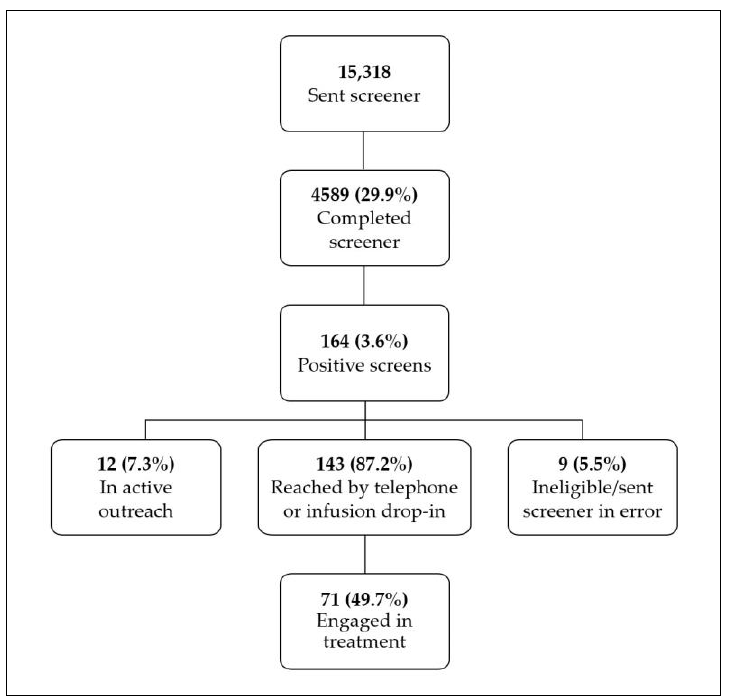
Figure 5. Tobacco screener completion and referrals for unique patients between June 25, 2019 and April 6 April 2020. Smoking within the last 30 days resulted in a positive 6, 2020. Smoking within the last 30 days resulted in a positive screen.